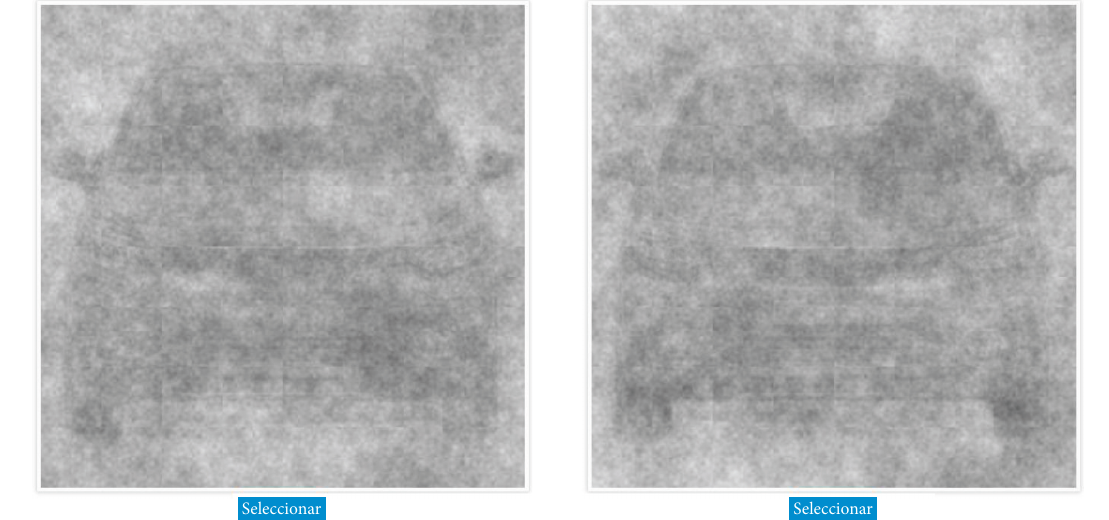
Figure 3: Stimuli pair presented to participants in one